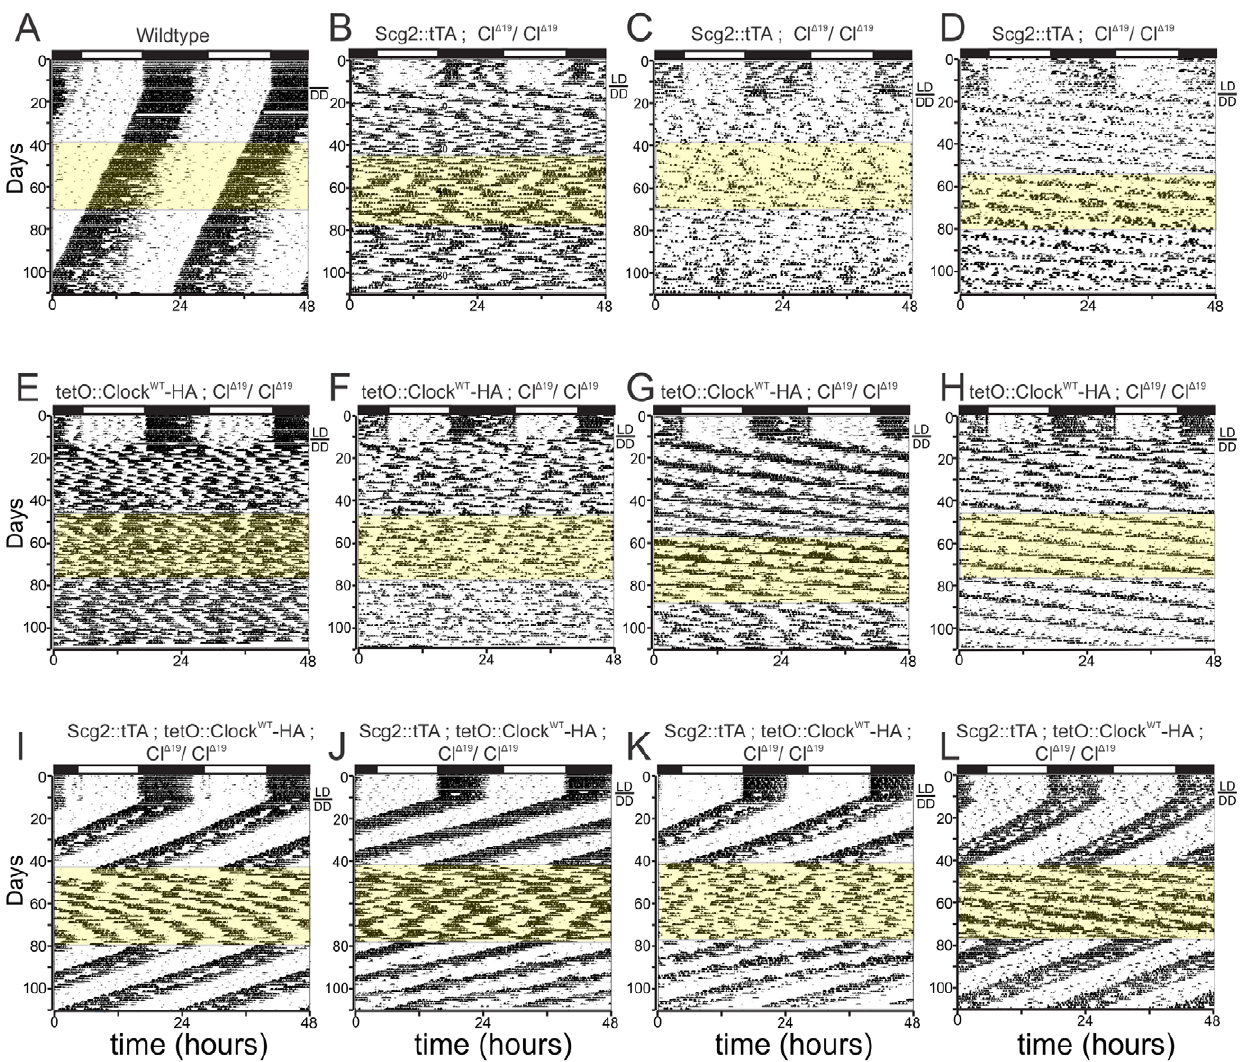
Figure 1. Reversible restoration of circadian rhythm in brain-rescued Clock mutant mice. Representative actograms of (A) wildtype mice, control littermates (B, C and D) Scg2::tTA; Cl D 19 /Cl D 19 , (E, F, G and H) tetO::Clock WT ; Cl D 19 /Cl D 19 , and (I, J, K and L) brain-rescued Clock mice ( Scg2 ::tTA;tetO:: Clock WT ; Cl D 19 /Cl D 19 ) on 10 m g/ml Dox treatment. Activity records were double plotted so that 48 hours is represented horizontally, with each day presented beneath and to the right of the preceding day. Wheel-running activity is indicated by black markings. The initial light cycle is depicted at the top of the record. All animals were maintained on a 12-hour light/12-hour dark cycle (LD) for the first 10 to 15 days shown and then transferred to constant darkness (DD), as indicated by the bar next to each record. The yellow shading denotes the time of Dox administration in DD. Brain-rescued Clock mice (I, J, K, and L) show restoration of free-running period in DD. When the mice are treated with Dox, brain-rescued Clock mice display loss of rhythmicity, similar to that of Clock mutant mice ( Cl D 19 /Cl D 19 ). A water washout returns the mice back to their rhythmic state. Control littermates (A–H) display no circadian rhythmicity in DD. Dox treatment has no effect on activity rhythm in control littermates or wildtype mice (A–H).